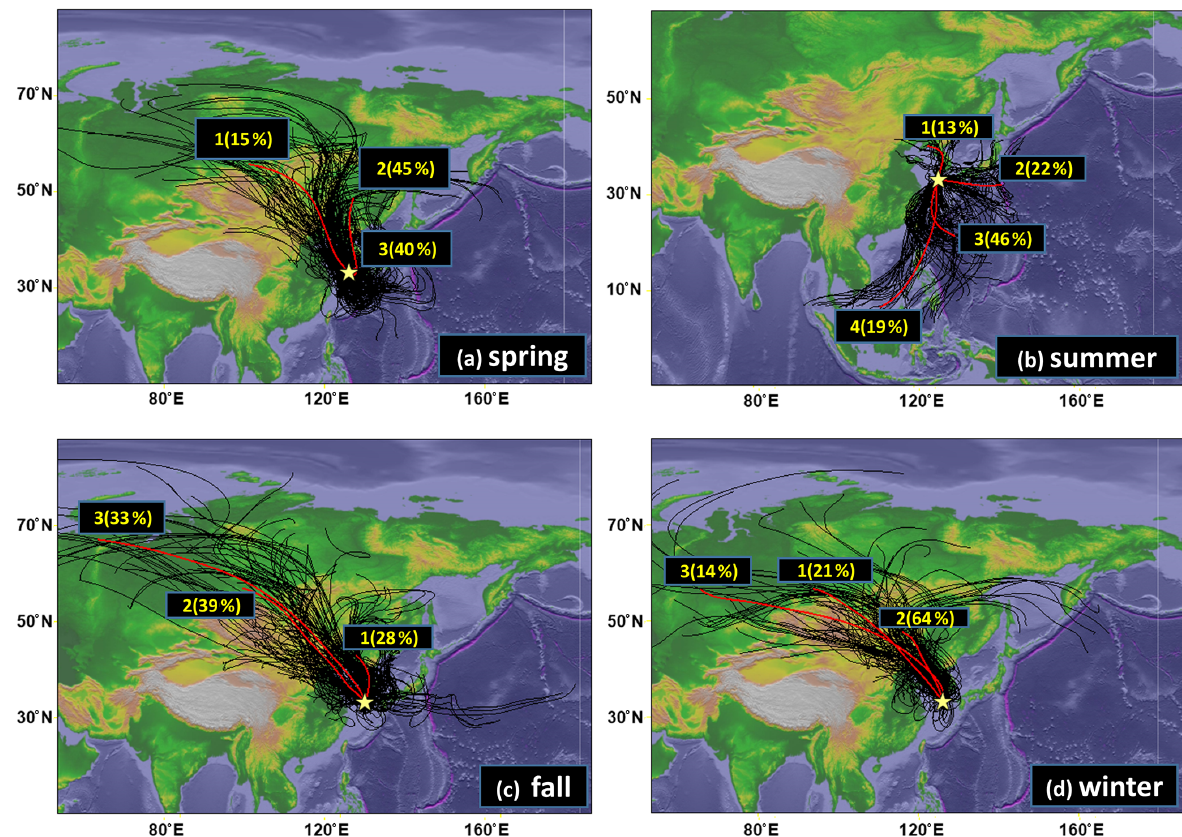
Figure 1. Cluster analysis of backward air mass trajectories over Gosan (indicated by a star) for the TSP collected during the (a) spring, (b) summer, (c) fall, and (d) winter